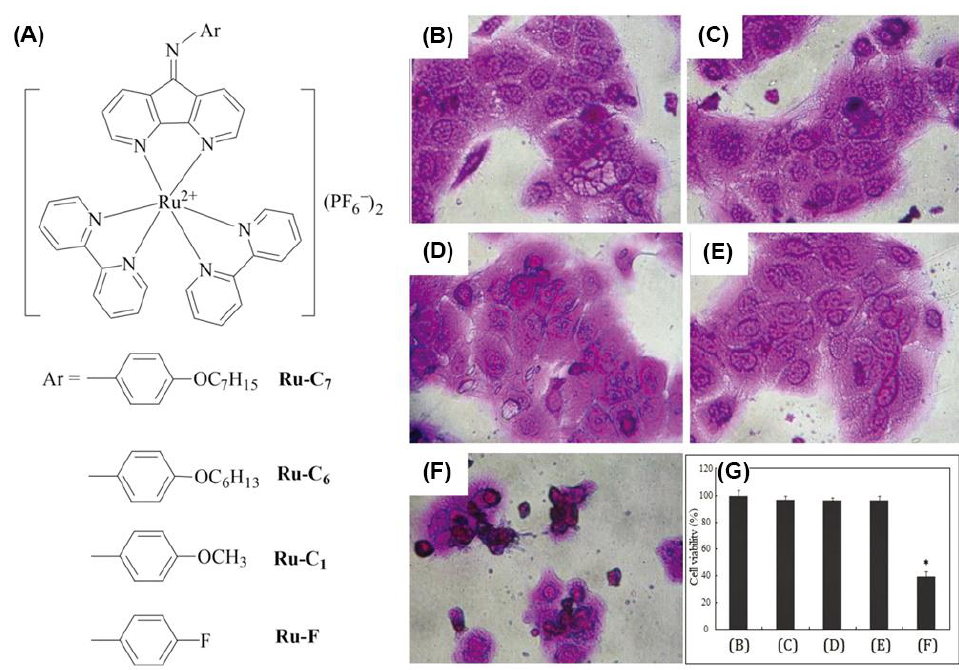
Figure 3. ( A ) Chemical structures of new ruthenium(II) complexes containing various N -phenyl-substituted 4,5-diazafluorenes;cytotoxicity evaluation of the ruthenium(II) complexes on human skin keratinocytes: ( B ) untreated control; ( C ) vehicle control (0.1% DMSO); ( D ) complex Ru- C6 (50 μg/mL); ( E ) complex Ru- C7 (50 μg/mL); ( F ) doxorubicin ( 2 μg/mL) ; and ( G ) cell viability of ruthenium(II) complexes towards human skin keratinocytes. Each experiment was carried out in triplicate and a mean value was obtained. Results were determined from three independent experiments and standard deviations are provided (reproduced with permission from Reference[53]).